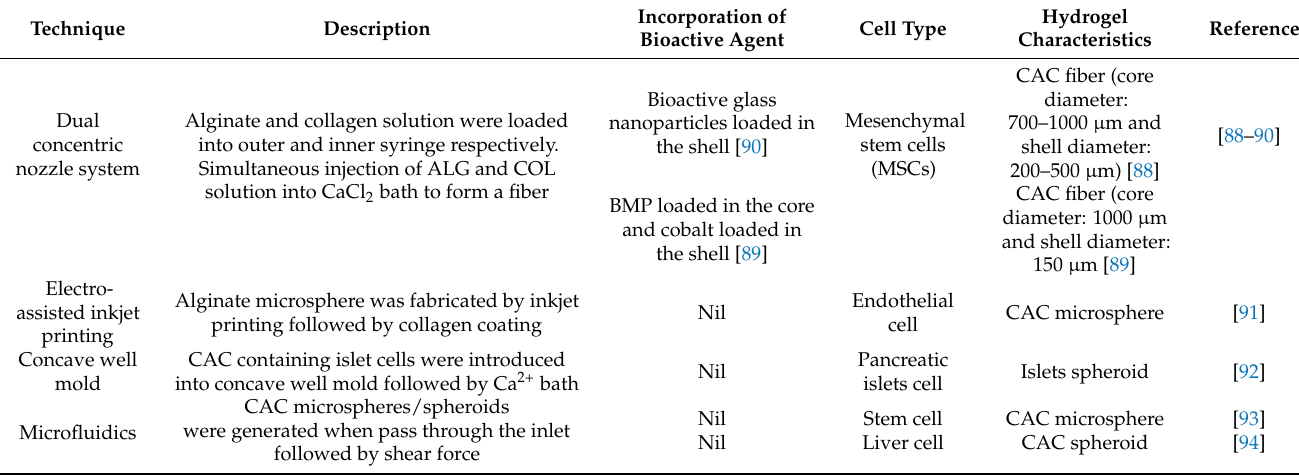
Table 2. Summary of novel techniques for the manufacture of CAC